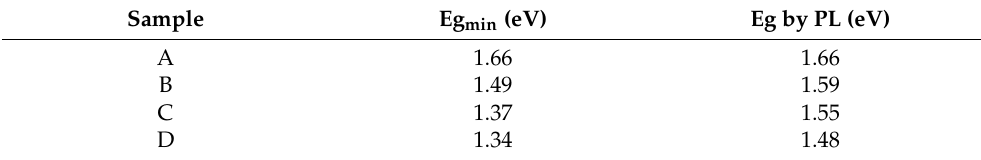
Table 4. The band gap of CIGS measured by EQE and PL.